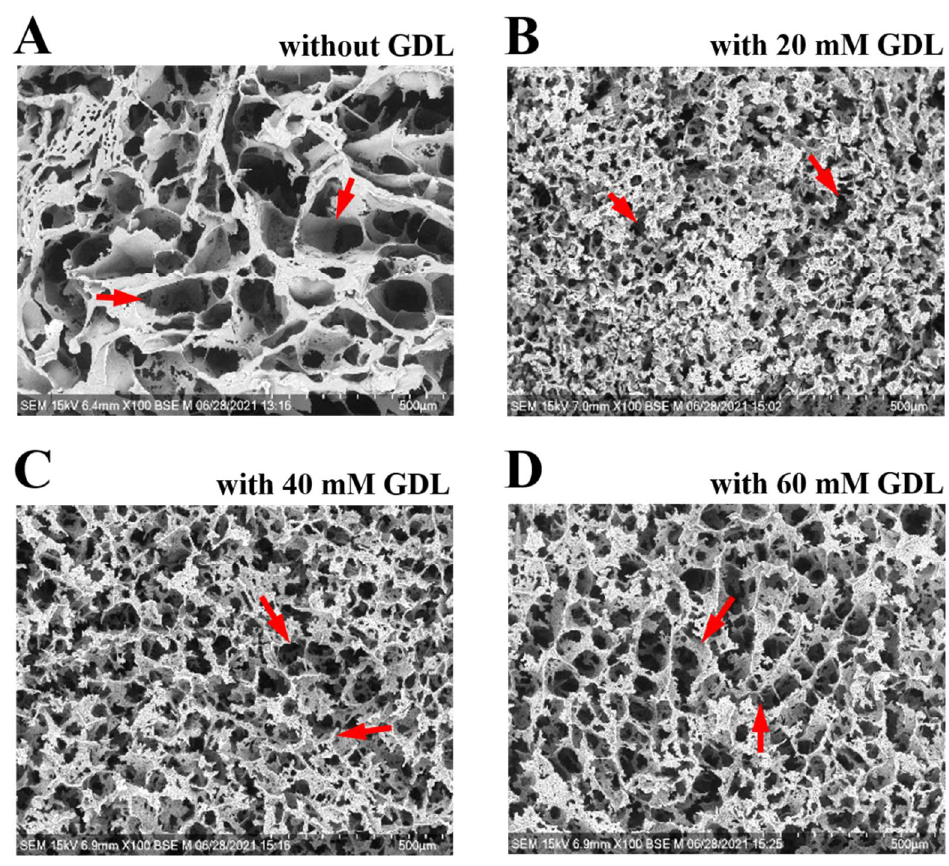
Figure 4. SEM images of pea-based tofu ( A ) without GDL, ( B ) with 20 mM GDL, ( C ) with 40 mM GDL, and ( D ) with 60 mM GDL. Red arrow: gel pore.